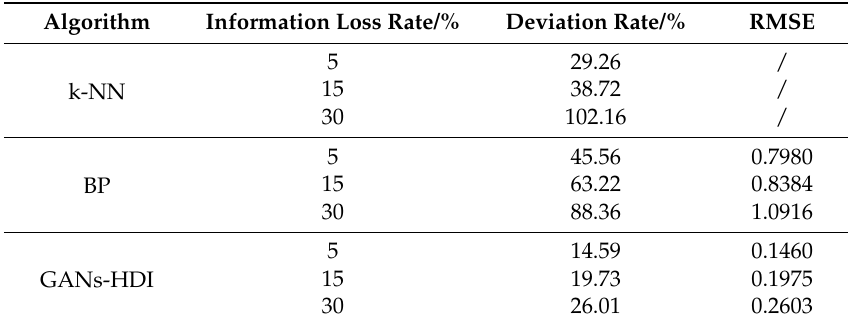
Table 8. Performance comparison on heterogeneous datasets for intelligent power distribution and utilization.